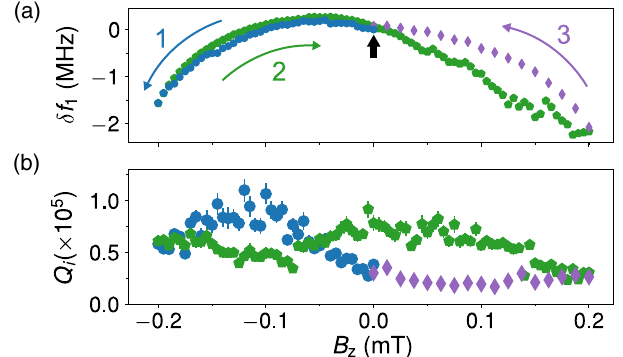
FIG. 12. Qubit response to out-of-plane magnetic fields. (a) Change in qubit frequency δ f 1 ¼ f 1 ð B of the out-of-plane compensation field B colored arrows indicate the order of the measurement cycle. (b) Internal quality factor Q the same measurement sequence. The internal quality factor exhibits a maximum around B 2 higher than the initial Q